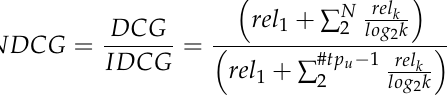
Ranking accuracy : We used three evaluation metrics for measuring the ranking accuracy of RSs to evaluate the systems. The area under the curve ( AUC ) of a receiver operating characteristics ( ROC ) curve in Equation (13) for each user u , which measures how accurate the